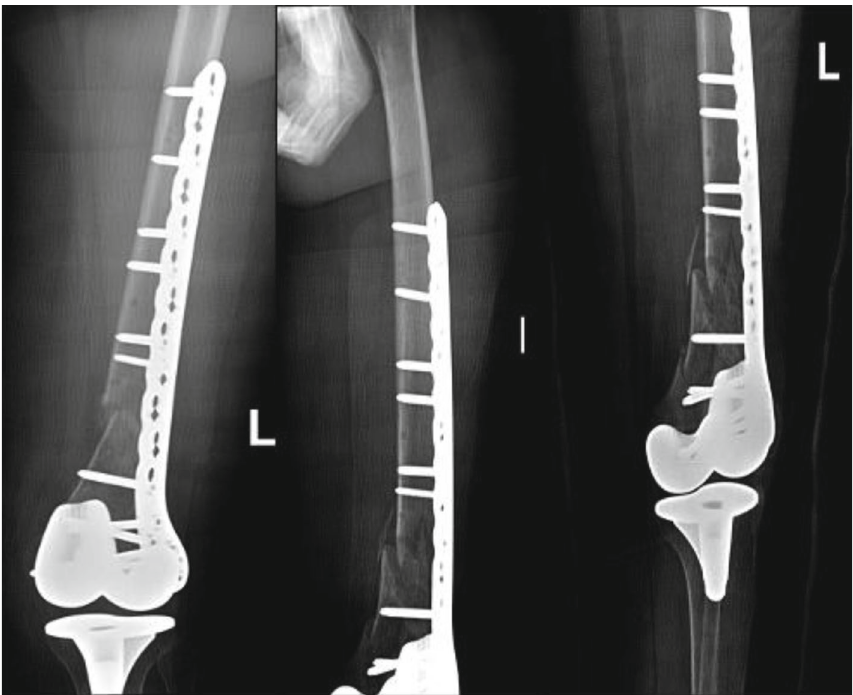
Figure 4: Postoperative follow-up A-P and lateral radiographs done two months postoperatively showing nonunion with severe comminution in the distal femoral region which is also associated with low bone stock.